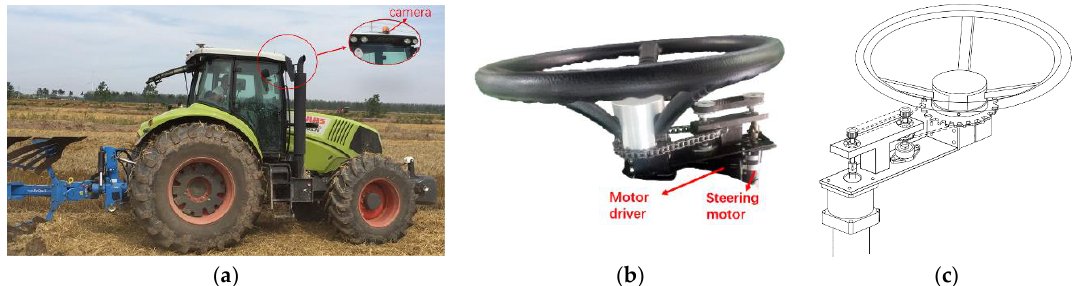
Figure 1. Intelligent tractor platform: ( a ) tractor platform; ( b ) steering configuration; ( c ) structural schematic diagram of the steering configuration.